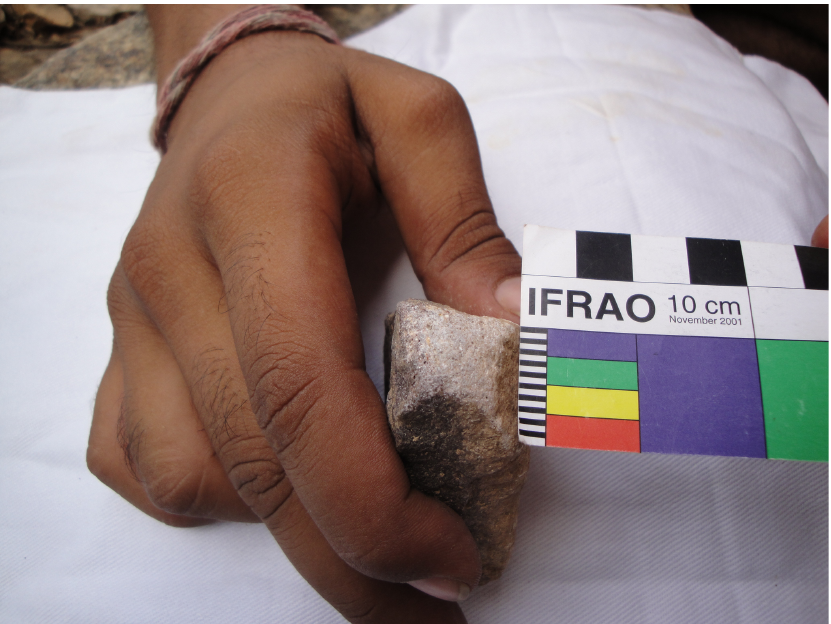
Figure 15. Striking head of the hammer stone on hard quartzite cobble used for making